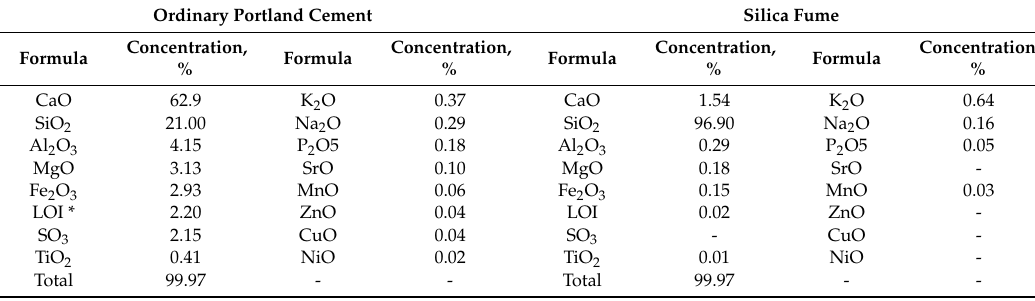
Table 2. Oxide compositions of ordinary Portland cement (OPC) and silica fume, wt.%.